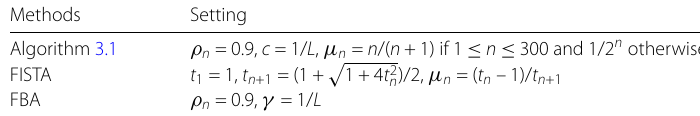
Table 1 Algorithms and their setting controls Methods Setting Algorithm